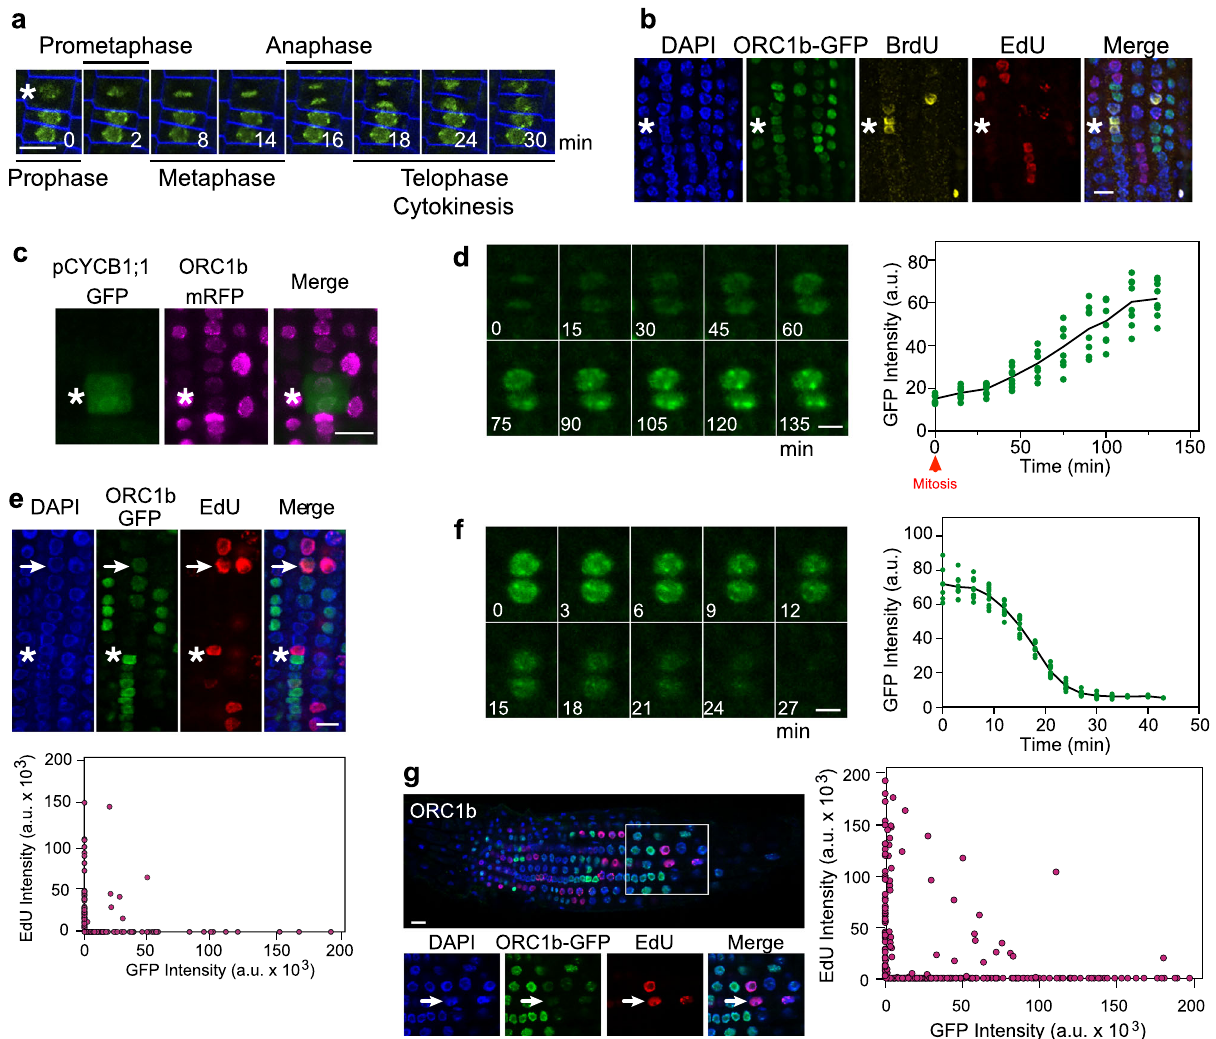
Fig. 2 | ORC1b dynamics during the cell cycle. a Representative live imaging of ORC1b-GFP roots ( n =6 movies) during mitosis. The asterisk marks a cell entering mitosis. ORC1b-GFP is shown at different time points, as indicated. The cellular plasmamembranewasstainedwithFM4-64(blue). b Identi fi cationofcellsinG2by immuno fl uorescent detection ( n =5 experiments). Roots were labeled for 15min with BrdU (yellow), chased for 2h with thymidine and then labeled with EdU (red) for15min.TheGFPsignal(green)wasimmunodetectedandallthenucleiidenti fi ed by DAPIstaining (blue).Asterisk markstwo nuclei in G2 (BrdU+, EdU – ) containing ORC1b-GFP. c Representative image ( n =9) of roots expressing ORC1b-mRFP (magenta) in G2 cells expressing CYCB1;1-GFP (green), as illustrated in the cell labeled with an asterisk. d Representative live imaging of ORC1b-GFP roots ( n =6 movies) during G1. Two cells that just fi nished cytokinesis are shown at different time points, as indicated (left panel). The GFP intensity during ORC1b-GFP loading was quanti fi ed (right panel; a.u.: arbitrary units; Supplementary Data 1). e Upper panel : S-phasecellsare depleted ofORC1b-GFP. Roots werelabeled for 15min with EdU (red),ORC1b-GFP(green) wasdetectedby immuno fl uorescence and all nuclei